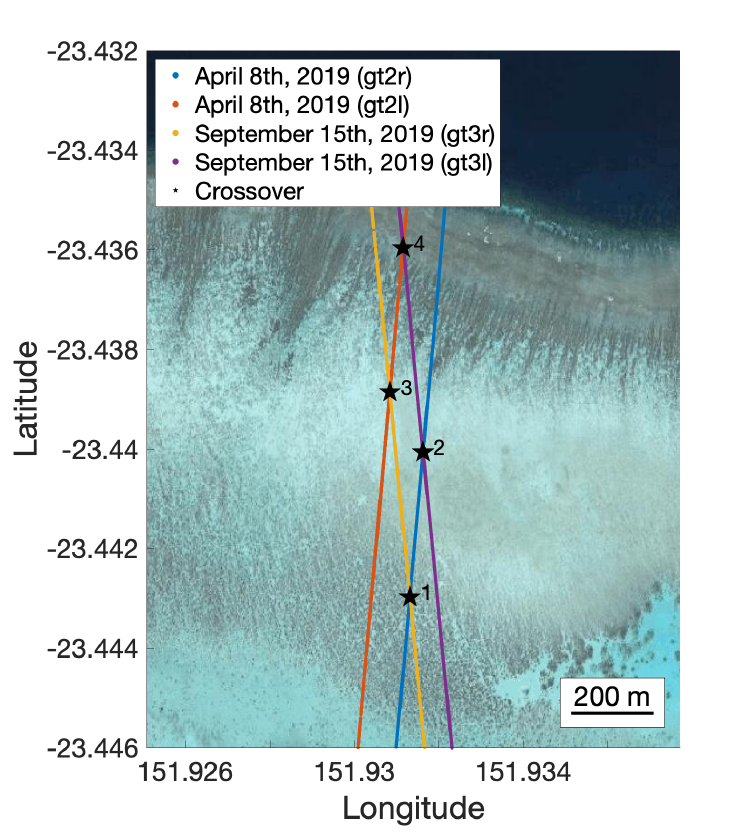
Figure 12. Crossover points over Heron Reef between two beam pairs from tracks 154 and 1213, on 9 April 2019, and 15 September 2019,